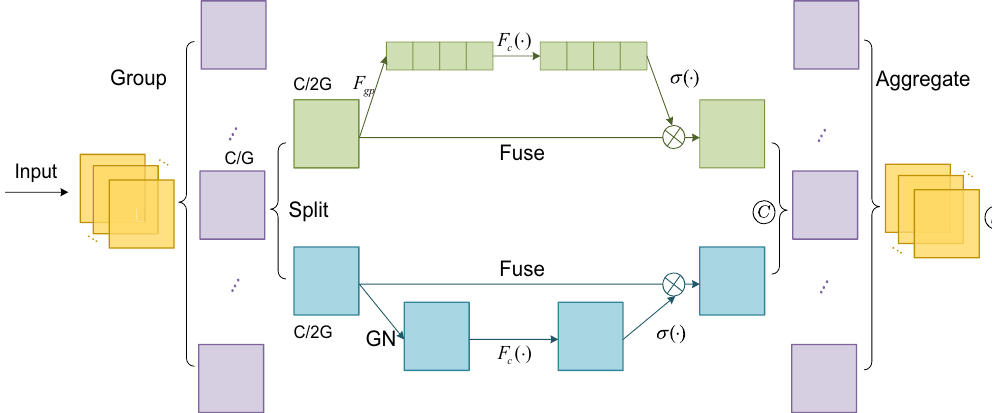
Figure 5. Shuffle attention.